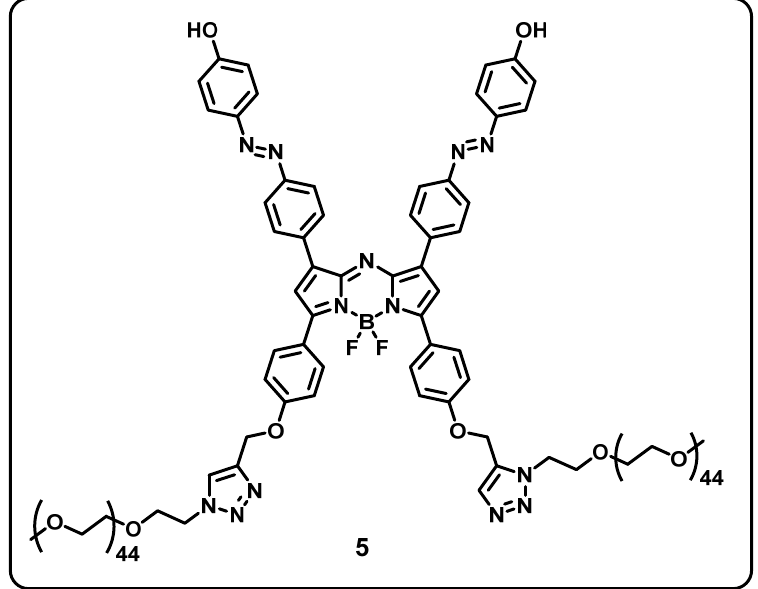
Figure 9. Structure of azobenzene-based BODIPY ( 5 ).